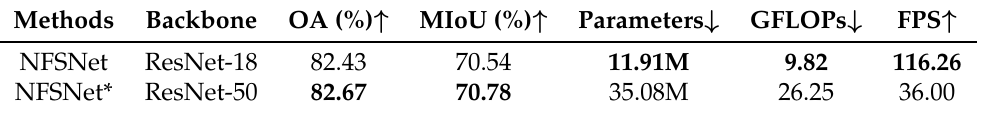
Table 6. Quantitative comparison results of backbone network based on Potsdam-A dataset. The high- est values for the different metrics are highlighted in bold, ↑ means the higher the better, ↓ means the lower the